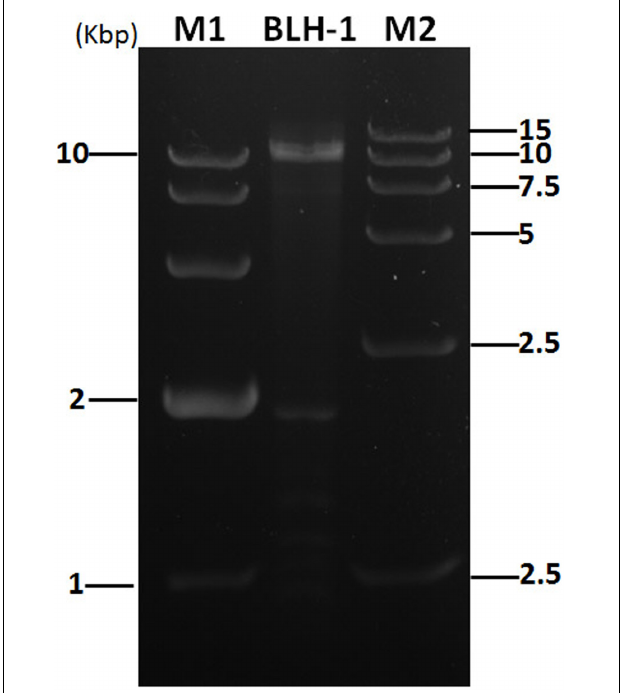
FIGURE 1 | dsRNA segments extracted from strain BLH-1 using the cellulose chromatography method were agarose gel-electrophoresed on 1% agarose before being digested with S1 nuclease and Dnase I to eliminate contaminated ssDNA and ssRNA. M1 and M2 represent the 10 and 15 kbp DNA markers,